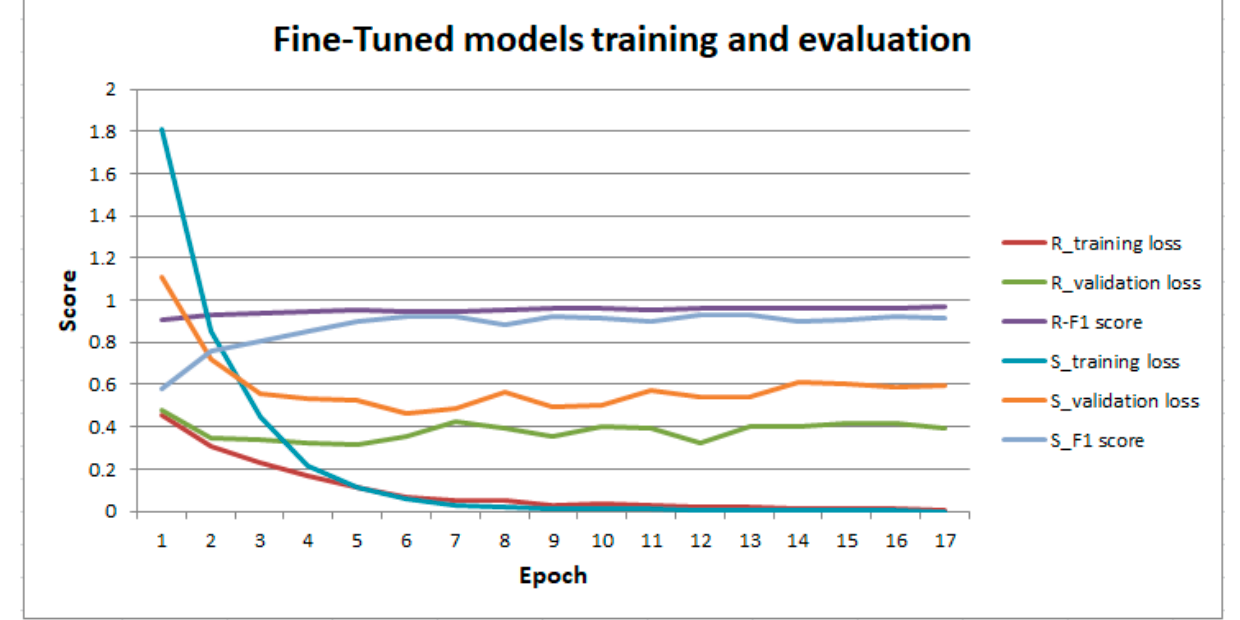
Figure 5. Training and evaluation of BERT word-based fine-tuned models for document classification based on relevance and subject.